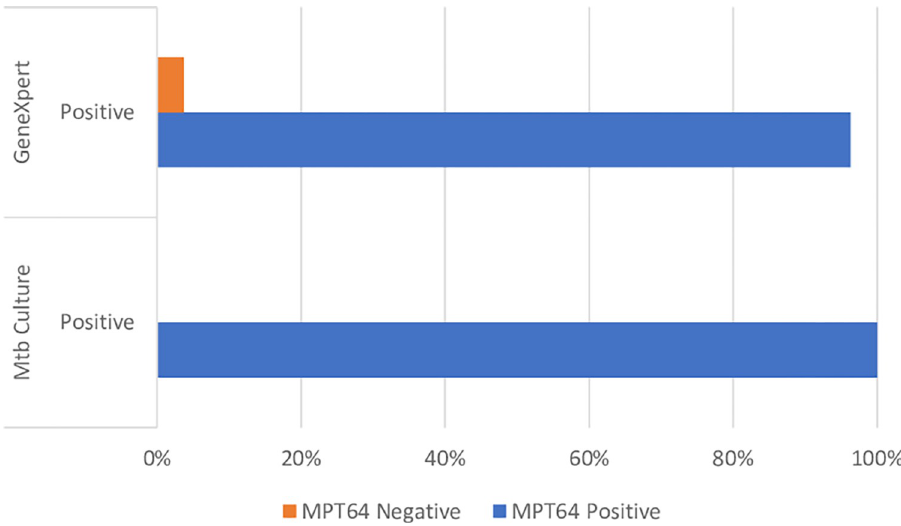
Fig 3. Positive mycobacterial culture/GeneXpert and correlation to MPT64 test result.